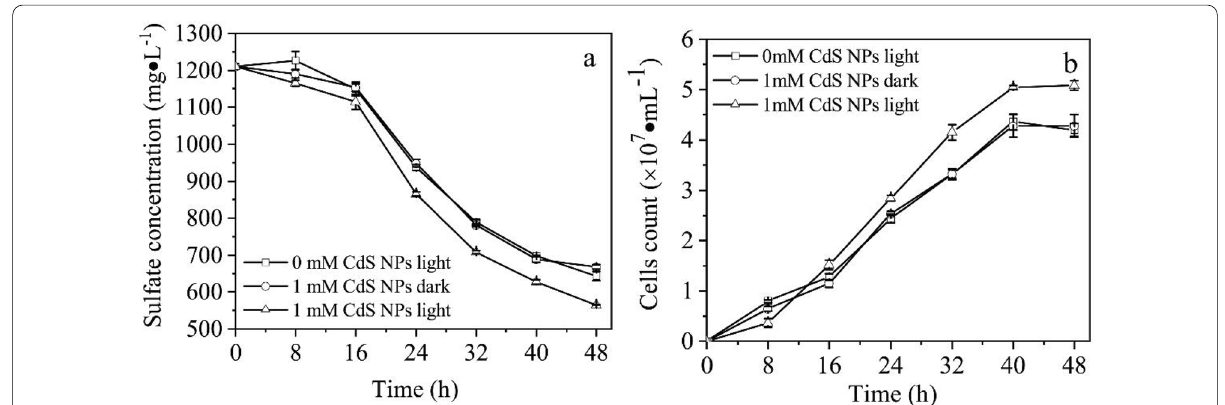
Fig. 3 Effects of the CdS NPs on C09 sulfate reduction and growth process. a Sulfate concentration; b